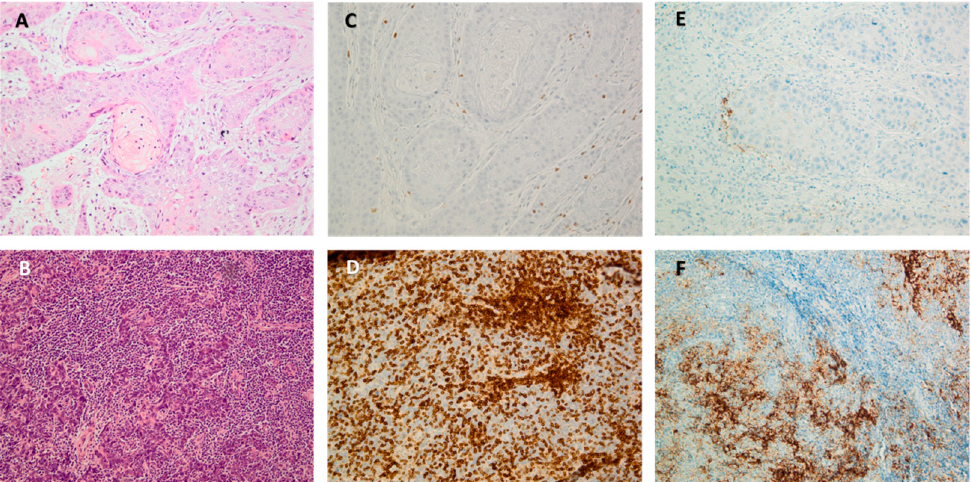
Figure 2. Stained squamous cell cancer of the head and neck (SCCHN) sections. ( A , B ) comparison of low versus high stromal tumor infiltrating lymphocyte (TIL) presence, stained with haematoxilin-eosin; ( C , D ) comparison of low versus high stromal CD3 + T cells, stained with CD3 primary antibody clone F7.2.38 (Dako, Glostrup, Denmark); and ( E , F ) comparison of low versus high PD-L1 expressing tumor and/or immune cells, stained with the PD-L1 clone 22C3 (Agilent-Dako, United States). A + C and B + D represent sections from the same patients.